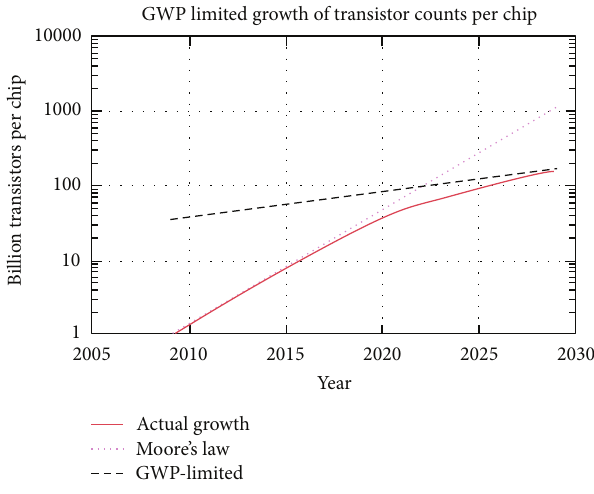
Figure 3: If costs for a single fab are at most 0.02% of the GWP (i.e., 𝜀 = 0.0002 ), a reduced growth of transistor counts per chip for economic reasons is likely to happen around 2020